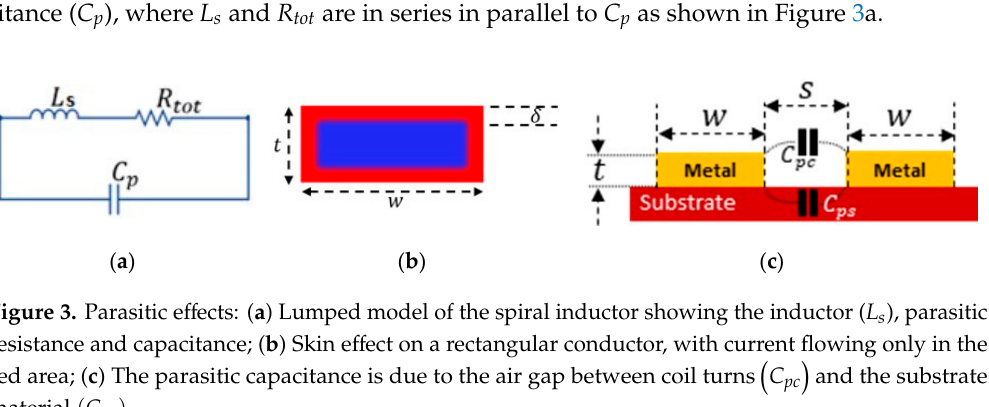
Figure 3. Parasitic effects: ( a ) Lumped model of the spiral inductor showing the inductor ( 𝐿 (cid:3046) ), parasitic resistance and capacitance ; ( b ) Skin effect on a rectangular conductor, with current flowing only in the red area; ( c ) The parasitic capacitance is due to the air gap between coil turns (cid:3435)𝐶 (cid:3043)(cid:3030) (cid:3439) and the substrate material (𝐶 (cid:3043)(cid:3046) ) .